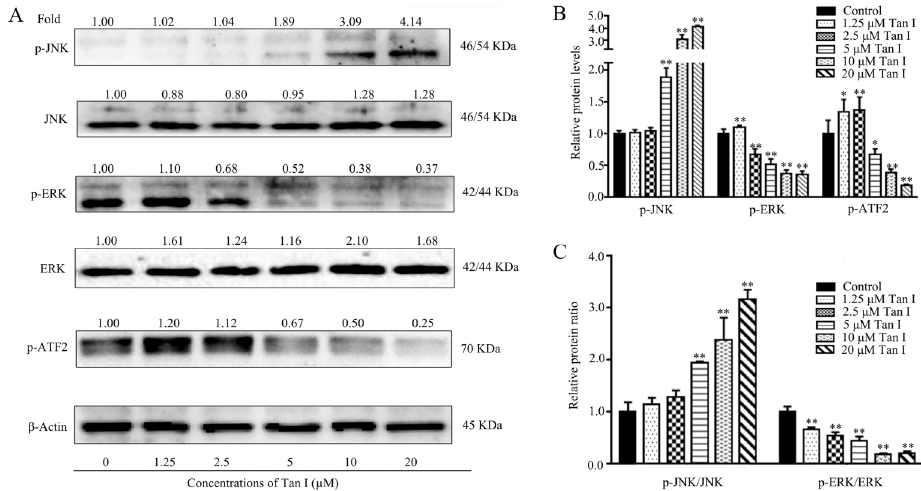
Figure 3. Effect of Tan I on the activities of JNK and ERK signaling pathways at different concentrations. A , Related protein expression levels of Tan I in K562 cells were determined with speci fi c antibodies by western blotting. B , The phosphorylation levels of JNK, ERK, and ATF2 were quanti fi ed by Image Lab software. C , The relative protein level ratios of p-JNK/JNK and p-ERK/ERK. Data are reported as means ± SD. *P o 0.05 and **P o 0.01 compared with the corresponding control group (ANOVA).